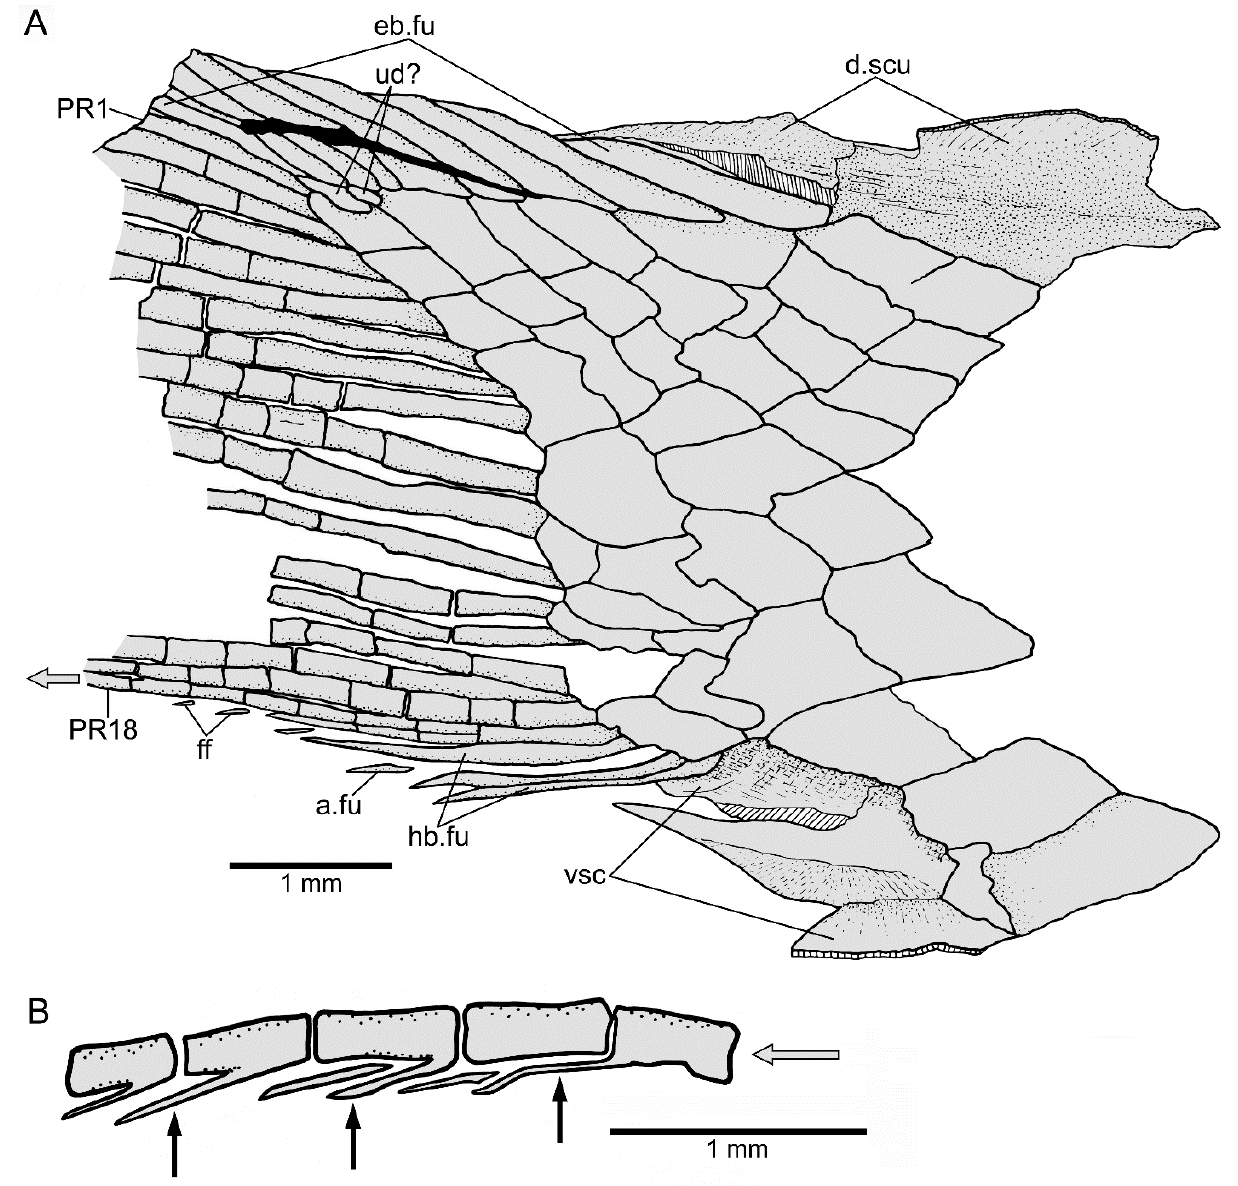
Figure 5. Seinstedtia parva gen. et sp. nov.; paratype MLU Sei.2010.36 in lateral view. ( A ) caudal fin and region in lateral view; ( B ) detail of a posterior segment of the last principal ray as indicated by gray arrows in ( A , B ). Black arrows point to projections of the caudal segments that look like fringing fulcra. Abbreviations: a.fu, additional fulcrum; d.scu, dorsal scute (broken); eb.fu, epaxial basal fulcra; ff, fringing fulcra; hb.fu, hypaxial basal fulcra; PR1–18, principal rays 1–18; ud?, urodermals?; vsc, ventral scute (broken). Black area indicates a fracture.